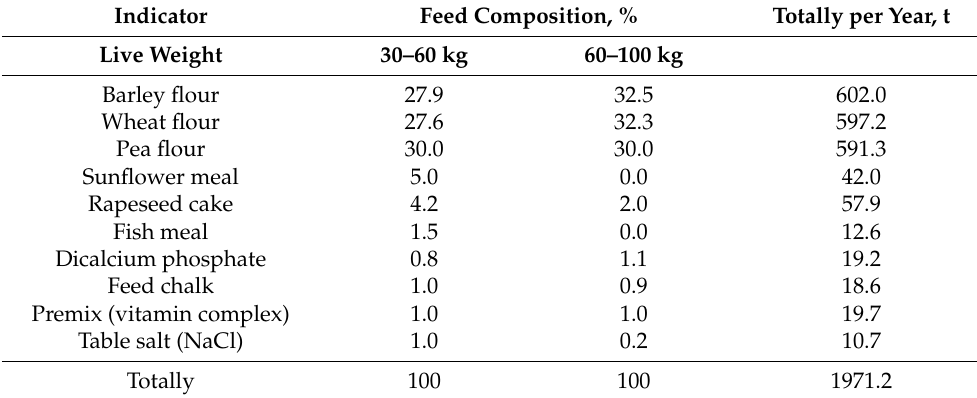
Table 2. Feed composition and consumption for pig rearing.